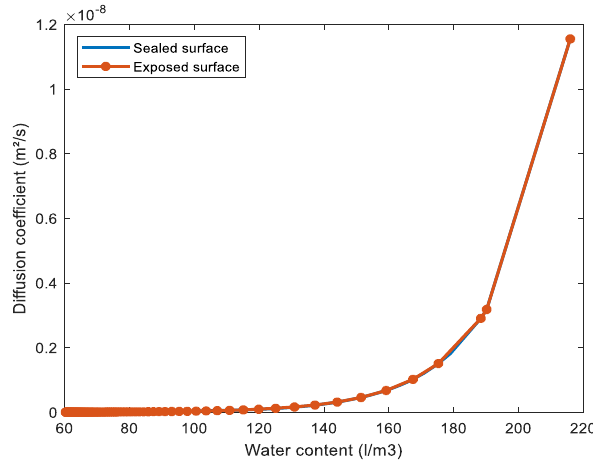
Figure 6: Di ff usion coe ffi cient.